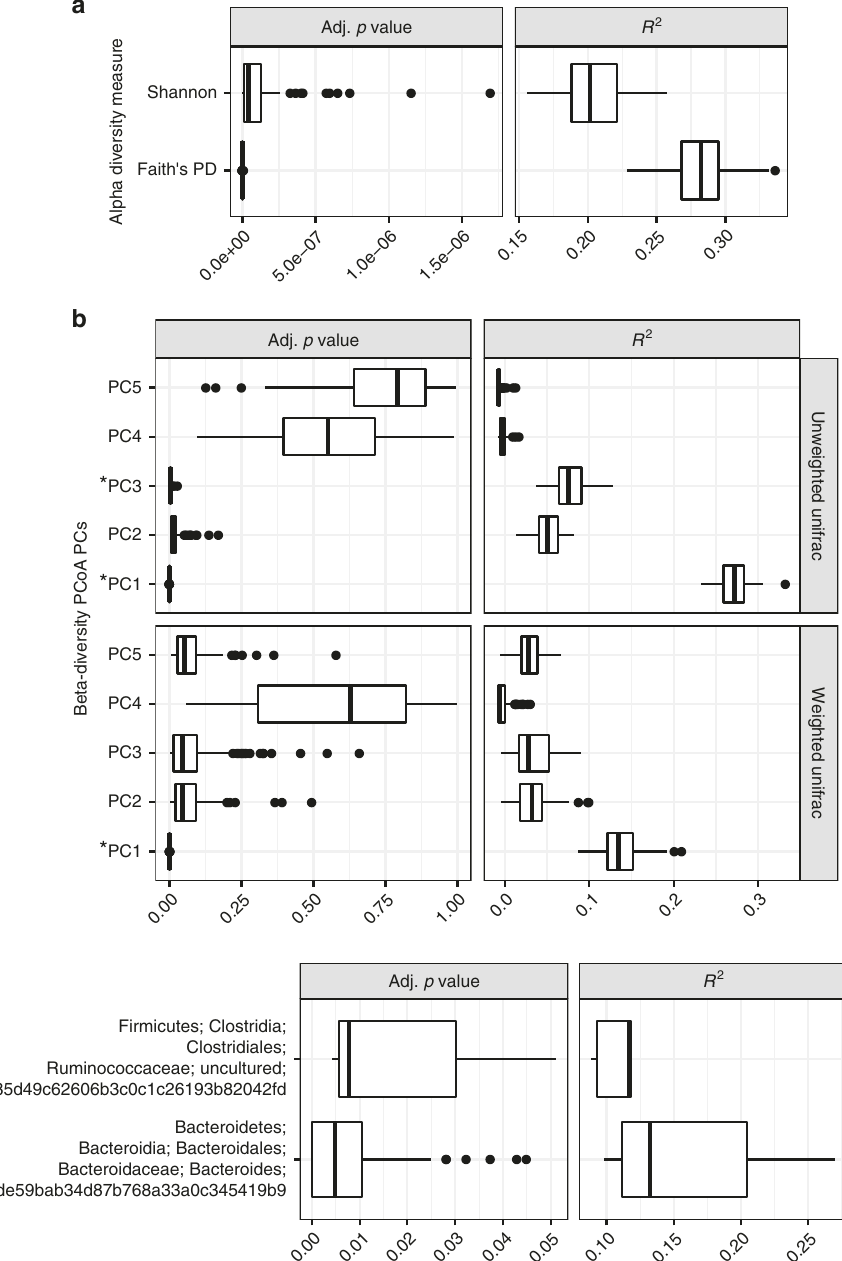
Fig. 3 After accounting for host phylogeny, diet signi fi cantly explained alpha- and beta-diversity components but could only explain the prevalence of two operational taxonomic units (OTUs). The boxplots are distributions of phylogenetic generalized least squares R 2 and Adj. p for 100 random subsamples of the datasets (one per species for each subsample). a Both alpha-diversity measures were found to be signi fi cant. b Some principal component (PC) analysis PCs were signi fi cantly explained by diet (asterisk denotes Adj. p < 0.05). The percentage of variance explained for each unweighted Unifrac PC is 18.1, 6.9, 4.2, 3.6, and 2.1 and each weighted Unifrac PC is 27.2, 10.6, 9.6, 6.4, 6.0, and 5.5. c Only two OTUs were found to be signi fi cant. Box centerlines, Data fi